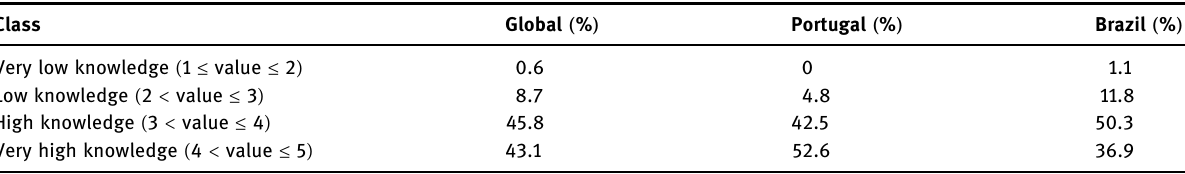
Table 5: Frequency of participants in the classes of knowledge Class Global ( % ) Portugal ( % ) Brazil ( % ) Very low knowledge ( 1 ≤ value ≤ 2